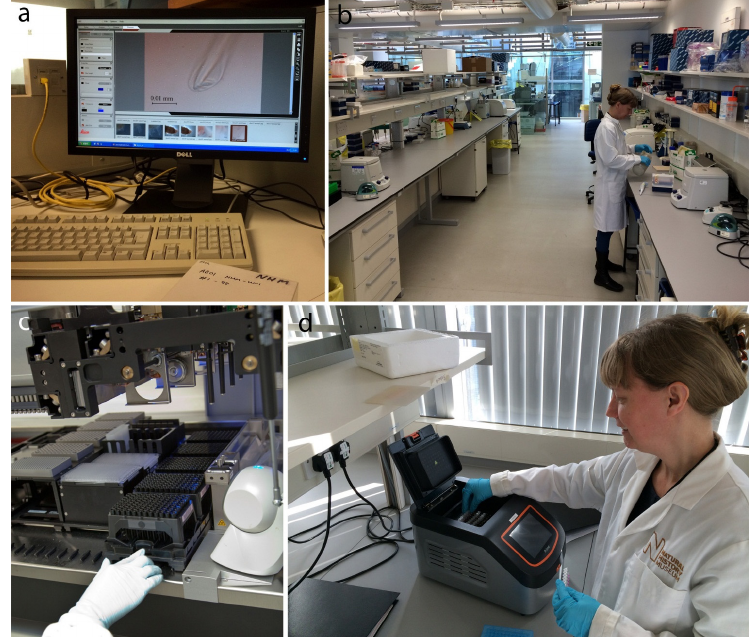
Figure 16. Laboratory pipeline for DNA taxonomy on return to institution (here Natural Museum, History Museum, London). ( a ) Second set of imaging of important morphological characters (here a polychaete chaetae); ( b ) DNA prep lab in the Darwin Centre; ( c ) Robotic workstation for automated DNA extraction and sequencing; ( d ) PCR machine.